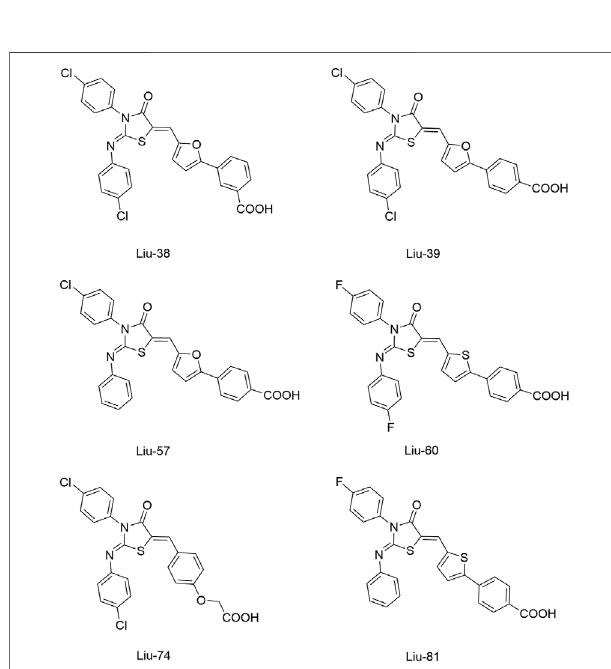
FIGURE 6 | The chemical structures of Liu-38, Liu-39, Liu-57, Liu-60, Liu-74, and Liu-81.